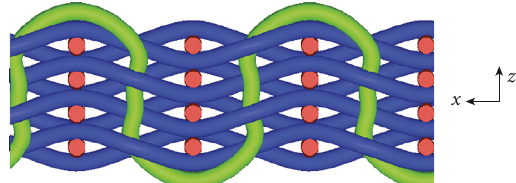
Figure 5: True packing of the 3D-woven reinforcement, illustrating the presence of partial overlap between warp